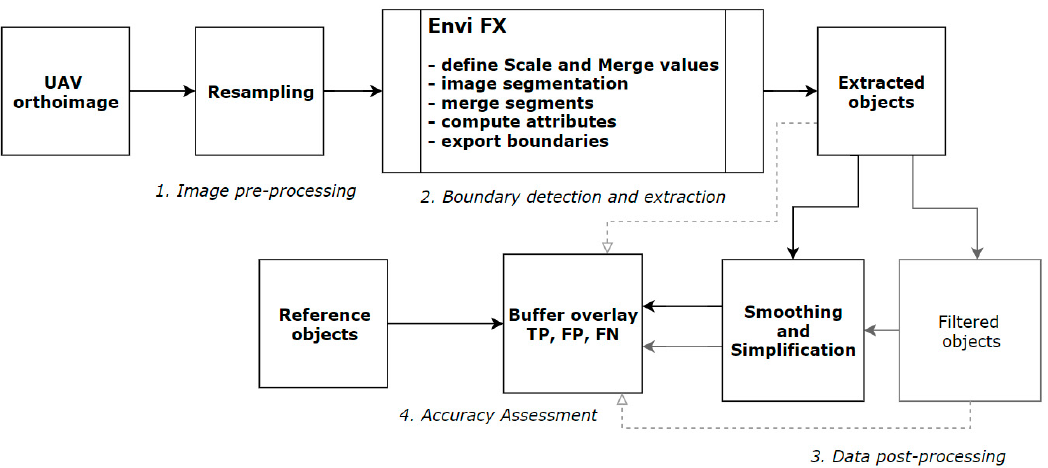
Figure 2. Cadastral mapping workflow based on the automatic detection and extraction of visible boundaries from UAV imagery.